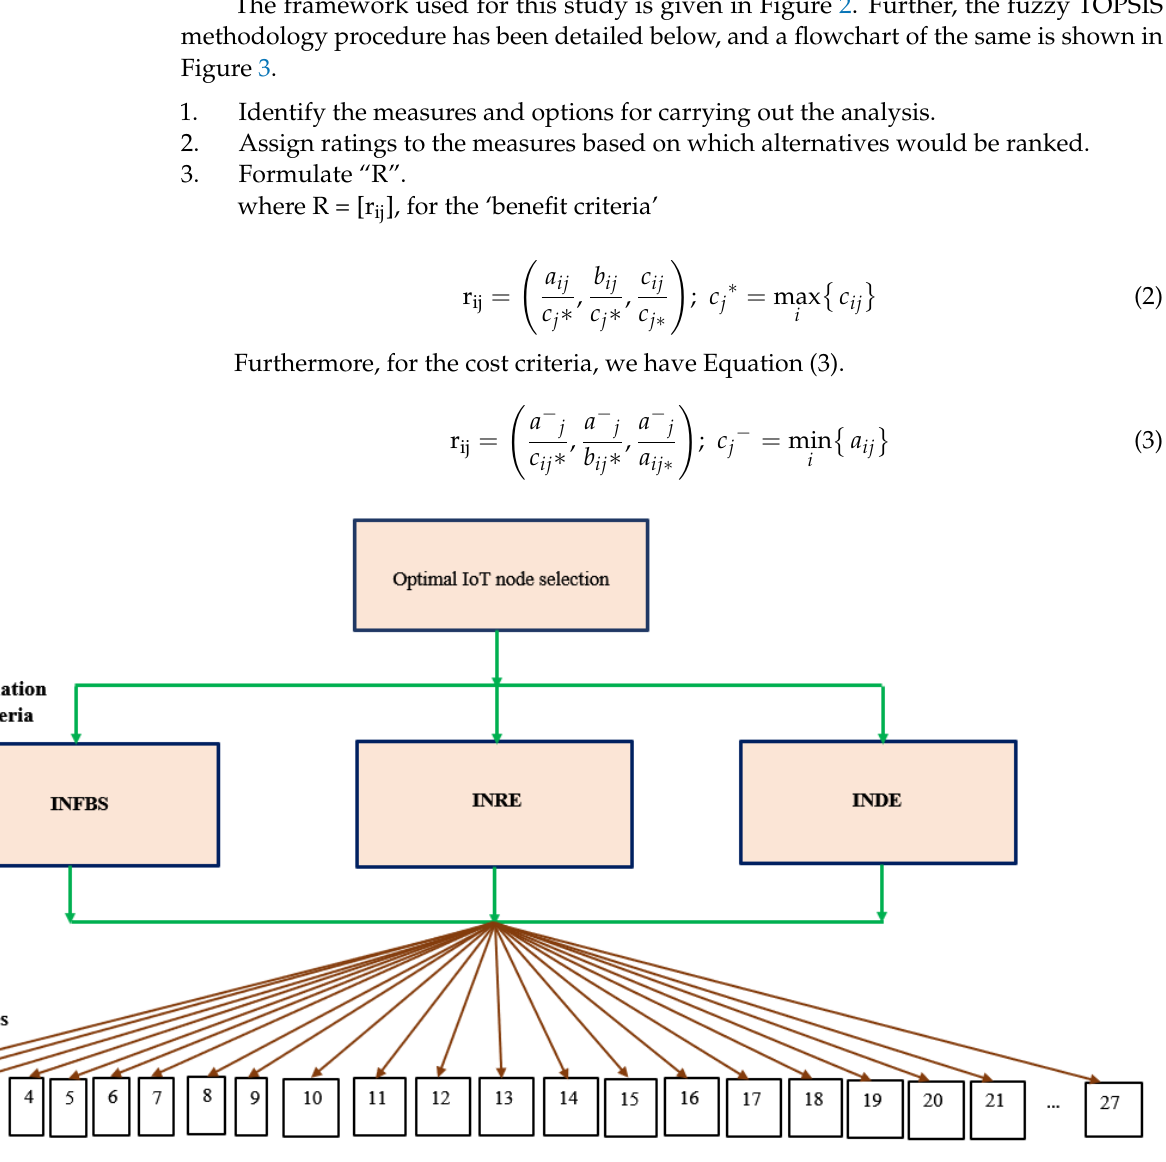
Figure 2. The framework used for the optimal node selection that indicates the evaluation criteria and the alternatives.